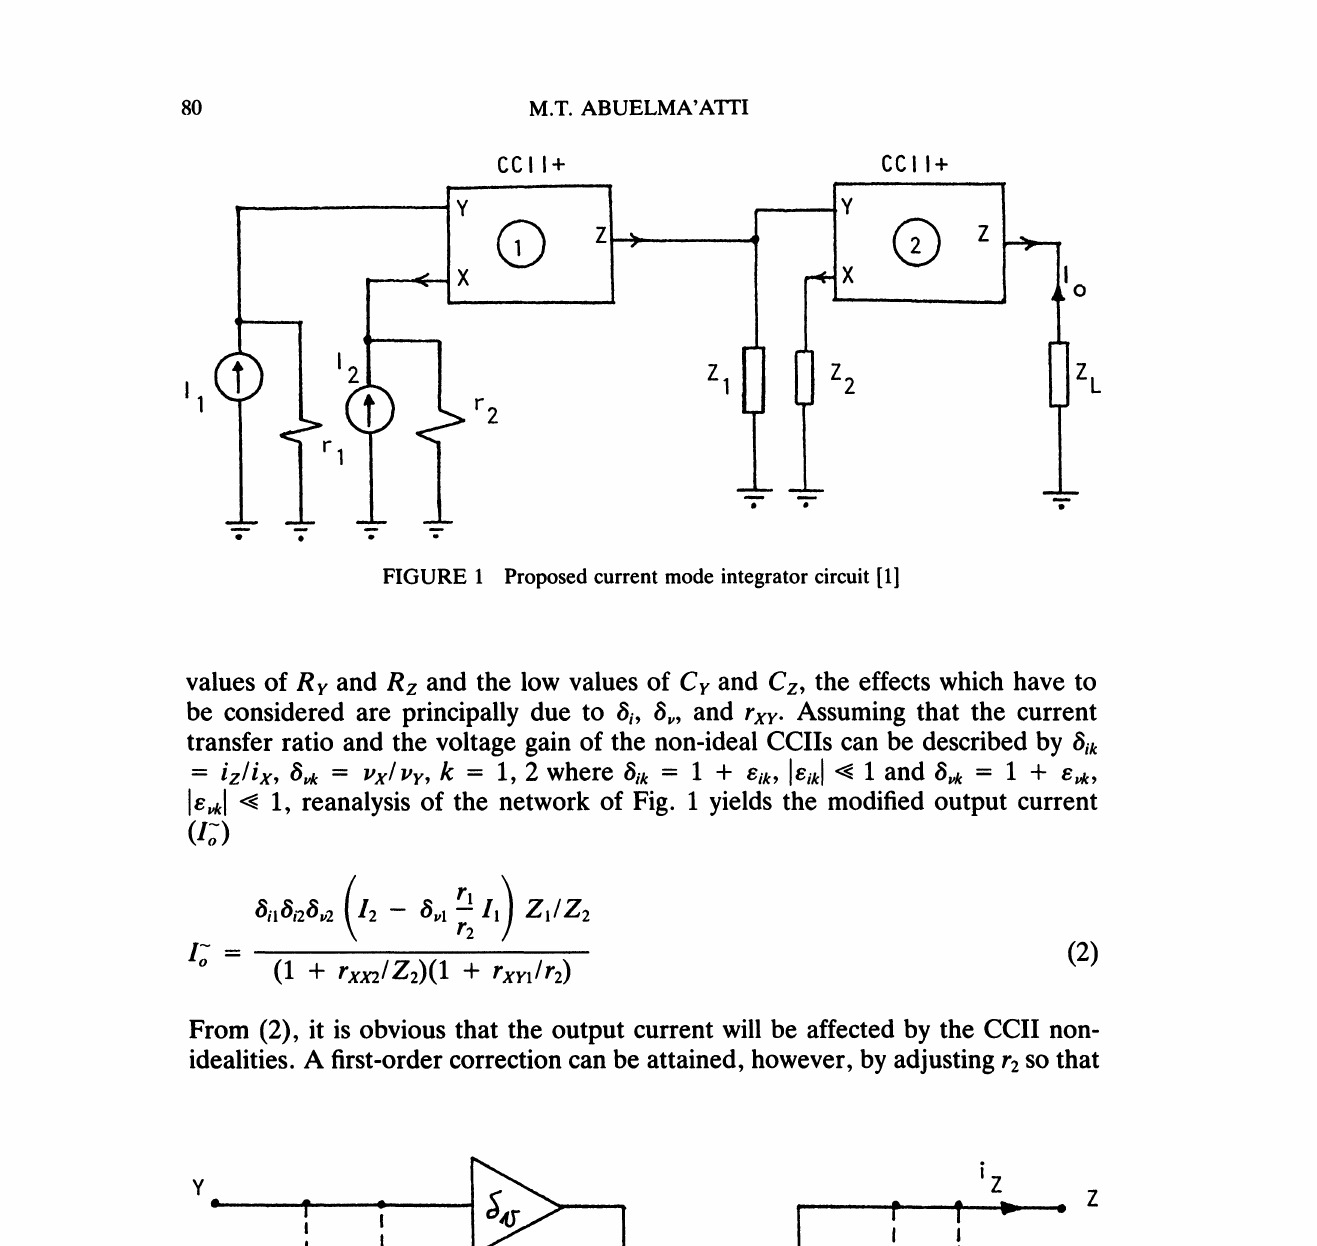
FIGURE 2 Simplified model for nonideal GCII